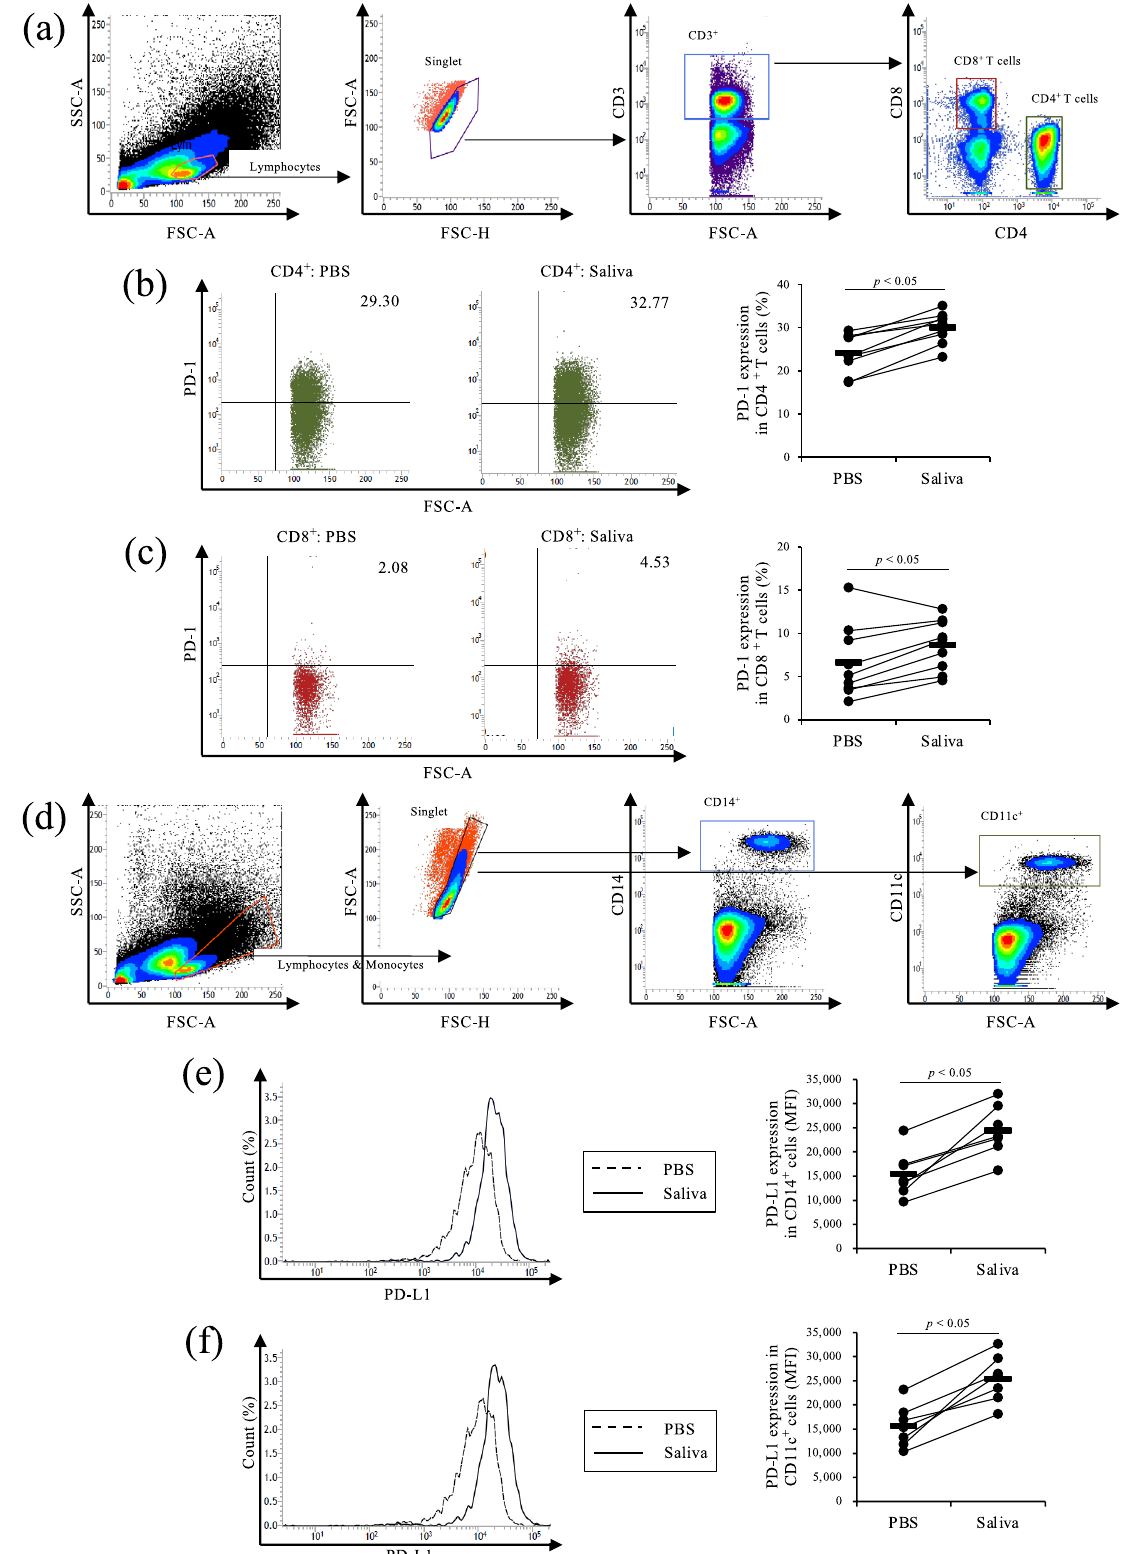
Figure 1. Upregulation of PD-1 and PD-L1 expression by Rhipicephalus microplus saliva (Rm-saliva). ( a – f ) PBMCs were cultured with Rm-saliva. ( a ) Gating strategy for PD-1 staining. ( b , c ) PD-1 expression in CD4 + ( b ) and CD8 + ( c ) T cells was measured by flow cytometry. ( d ) Gating strategy for PD-L1 staining. ( e , f ) PD-L1 expression in CD14 + ( e ) and CD11c + ( f ) cells was measured by flow cytometry. ( a – f ) Statistical difference was identified by the Wilcoxon signed-rank test. MFI mean fluorescence